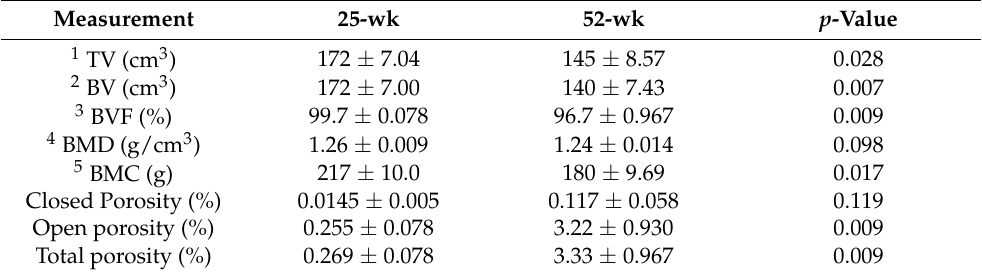
Table 4. Morphology, based on micro-CT scanning, of cortical bone from Hy-Line W36 hens. Measurement